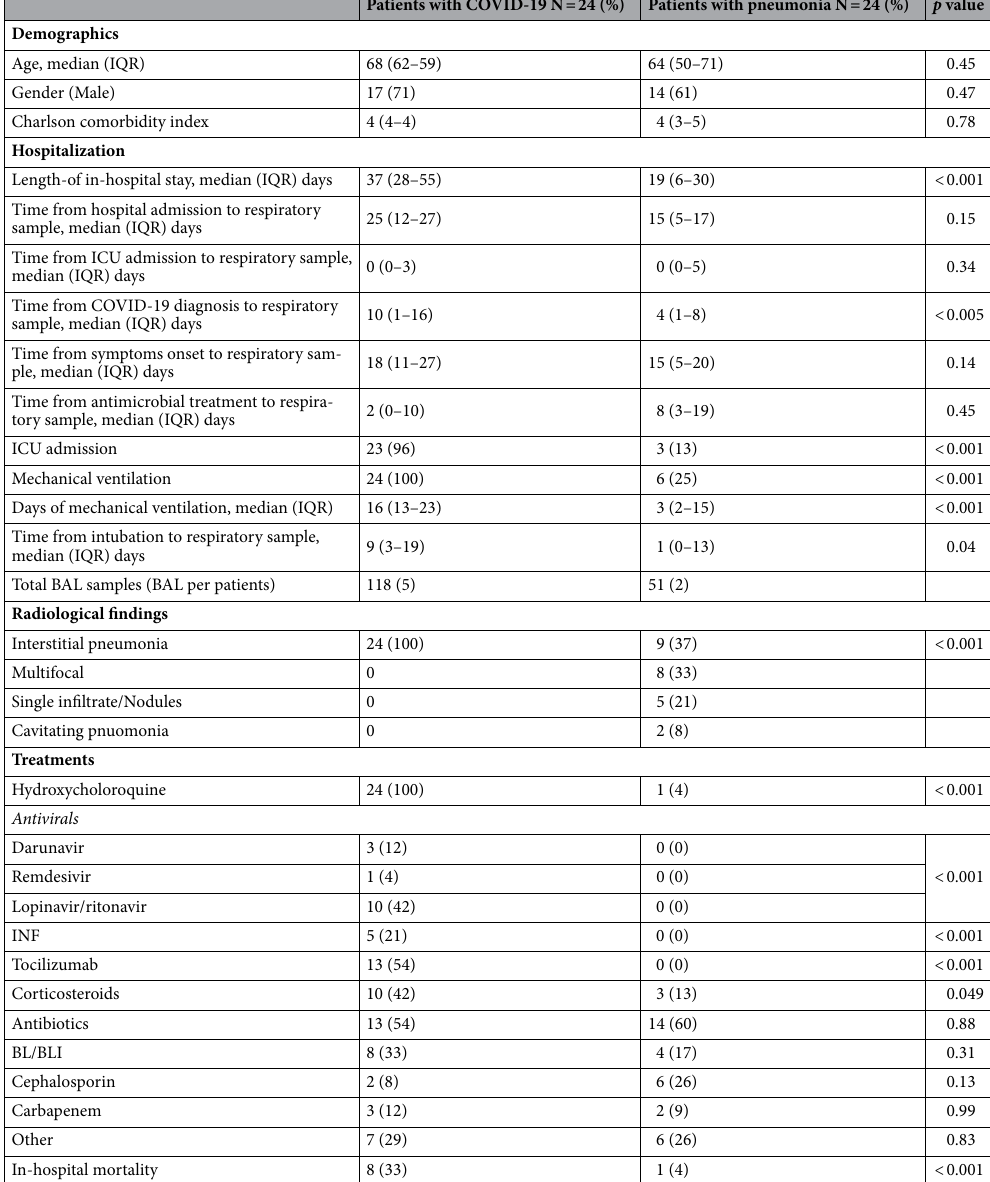
Table 1. Clinical characteristics of critically ill patients with COVID-19 compared with negative subjects with